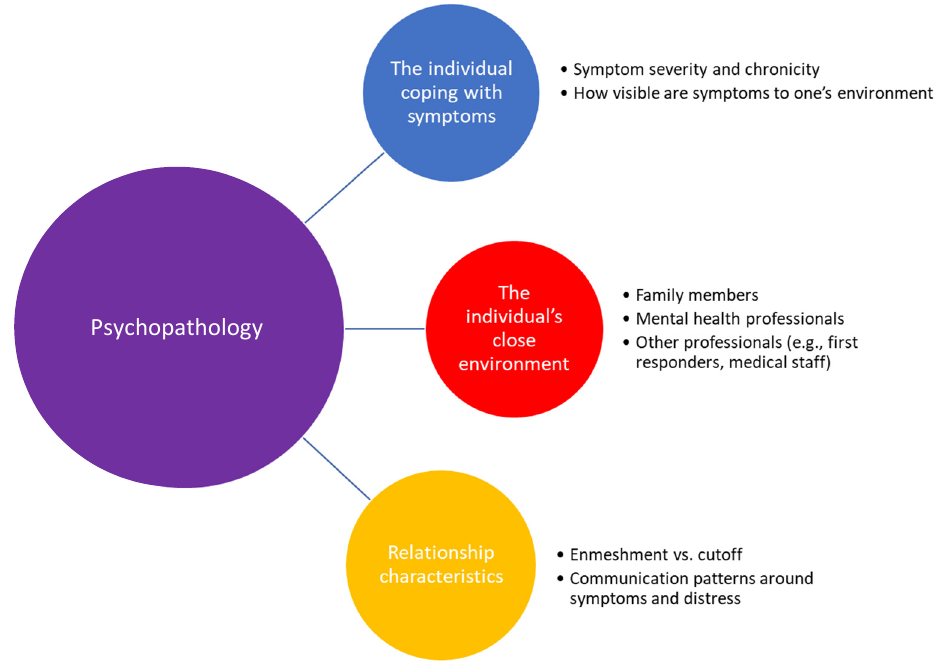
Figure 1. Theoretical model of cross-diagnostic emotional contagion/symptom transmission.